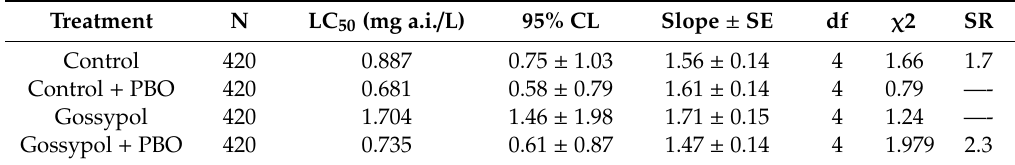
Table 1. The influences of gossypol ingestion and synergism e ff ect of piperonyl butoxide (PBO) on the deltamethrin toxicity to S. exigua